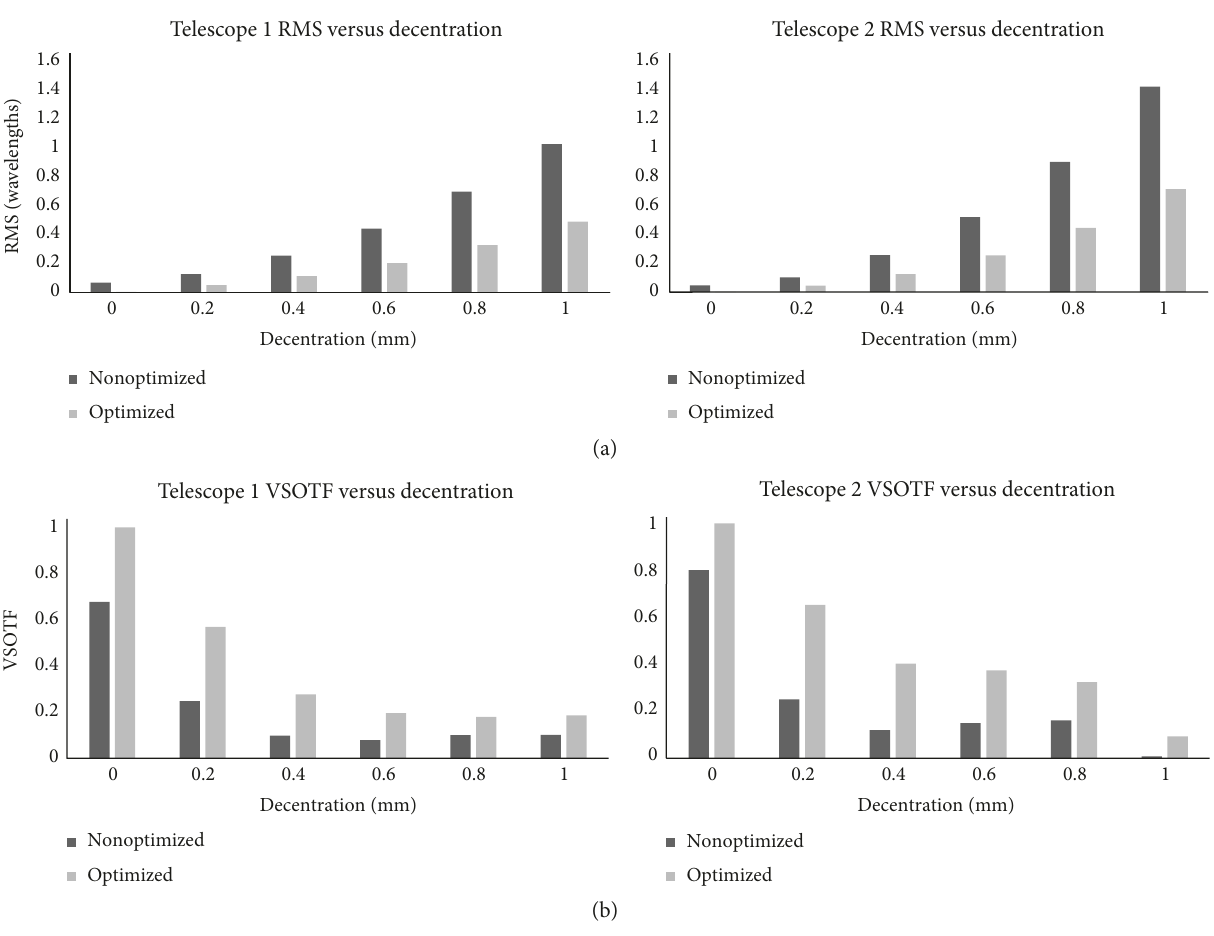
Figure 6: Telescope root mean square (RMS) wavefront error (a) and visual Strehl ratio (VSOTF) (b) versus decentration of the anterior